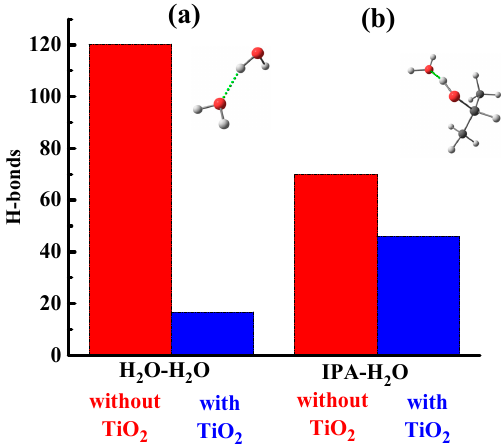
Figure 12. Number of hydrogen bonds between ( a ) water molecules and ( b ) water and isopropanol molecules per 100 solvent molecules.